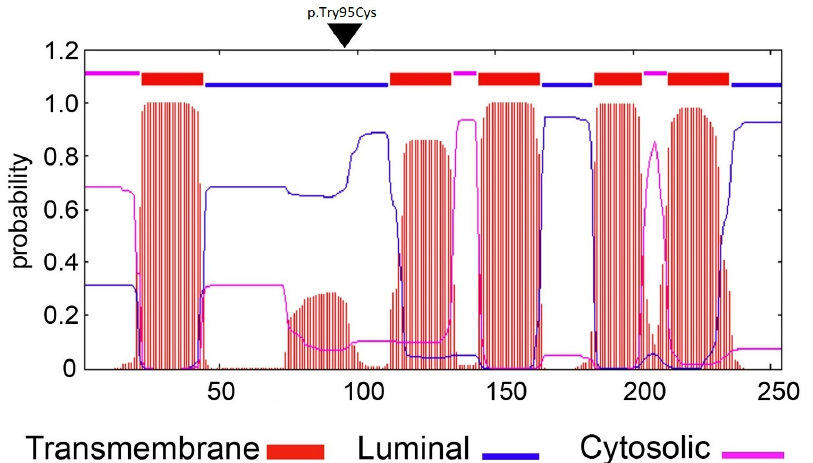
Figure 4. The likely pathogenic PGAP2 variant is shown in context of the isoform 8 (arrow). PGAP2 c.284A>G in the transcript 12, isoform 8 (NM_001256240) encoding p.Try95Cys was tested in the rescue assay. Transcript 1 encodes the less active isoform 1 whereas transcript 12, lacking 61 amino acids translated from exon 3, encodes the more active form as previously described [28]. The predicted topology of the PGAP2 protein was modeled using TMHMM (http://cbs.dtu.dk/services/TMHMM/) (accessed on 1 December 2022).